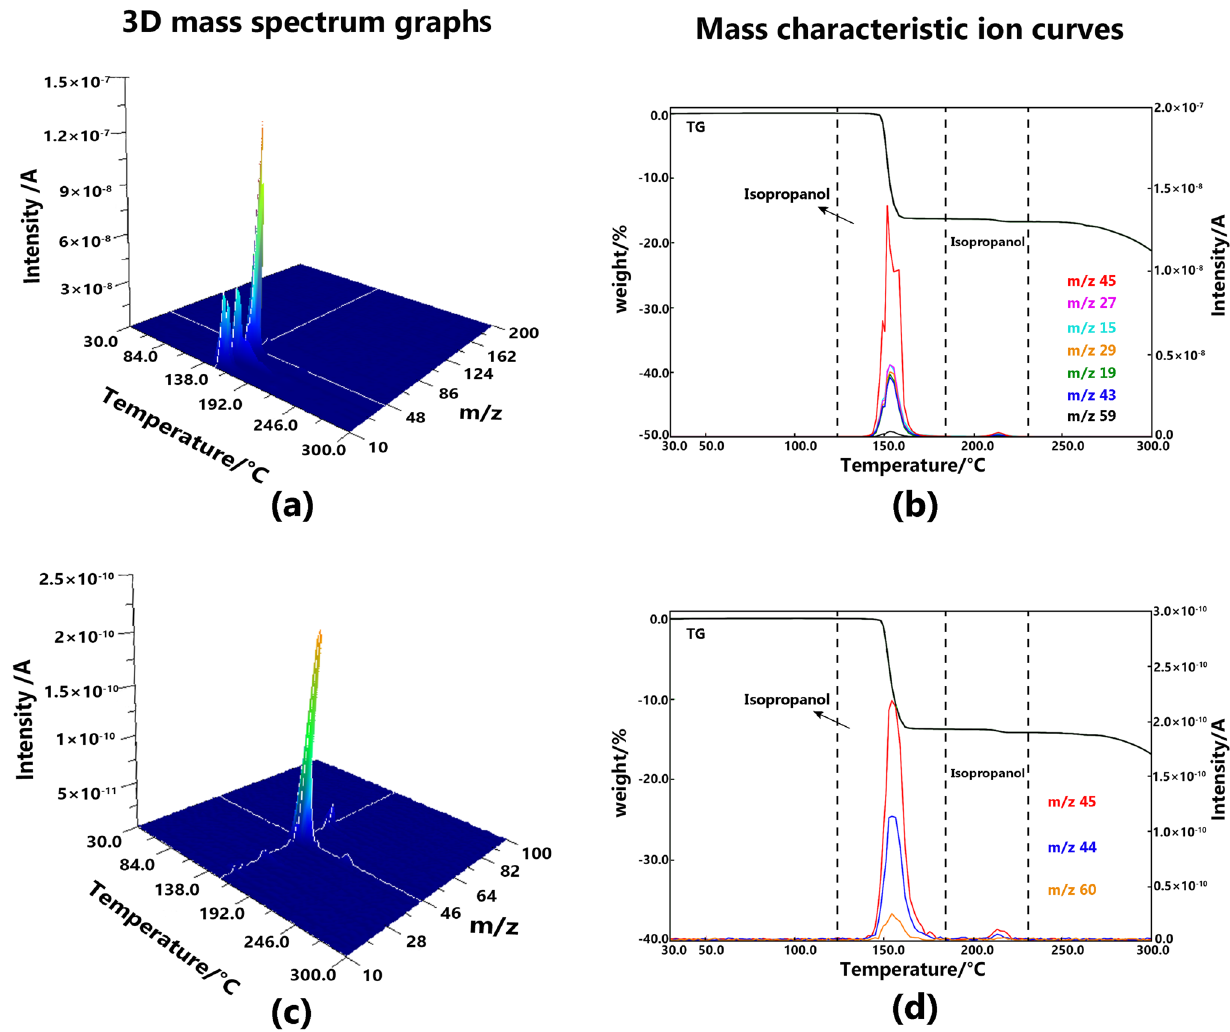
Fig. 6 3D mass spectrum graphs of solvatomorph V measured at EI method ( a ) and PI method ( c ), mass characteristic ion curves solvatomorph V measured at EI method ( b ) and PI method ( d